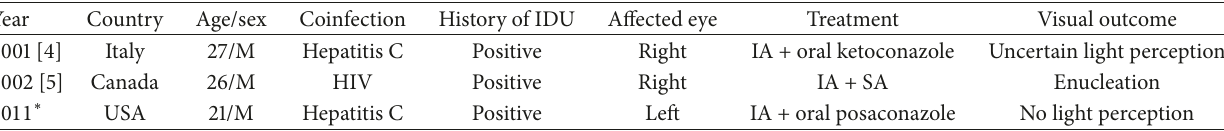
Table 1: Rhodotorula endogenous endophthalmitis cases to present.